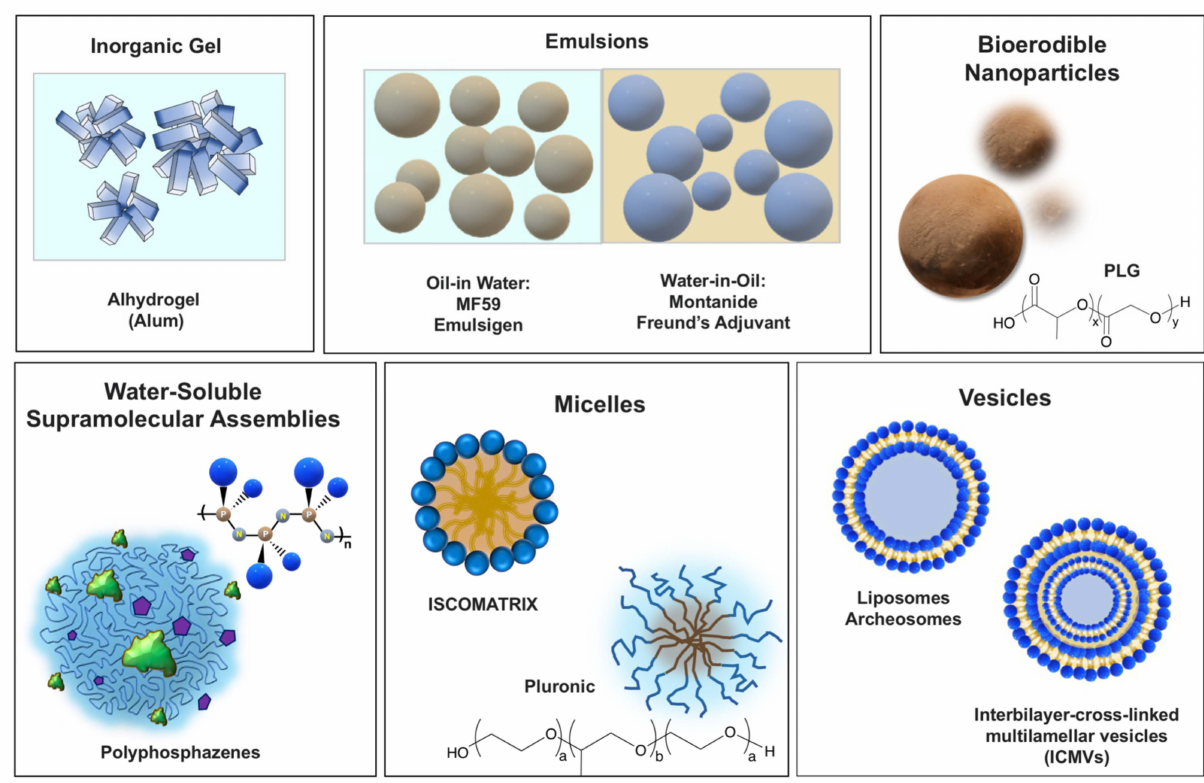
Figure 1. Vaccine adjuvants with predominant delivery function grouped based on their physico-chemical